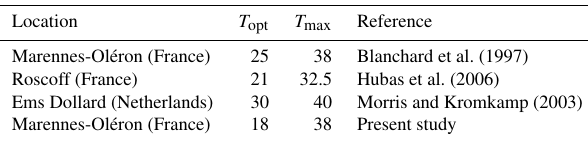
Table 6. Temperature optimum and maximum for photosynthesis ( T opt and T max , respectively; ◦